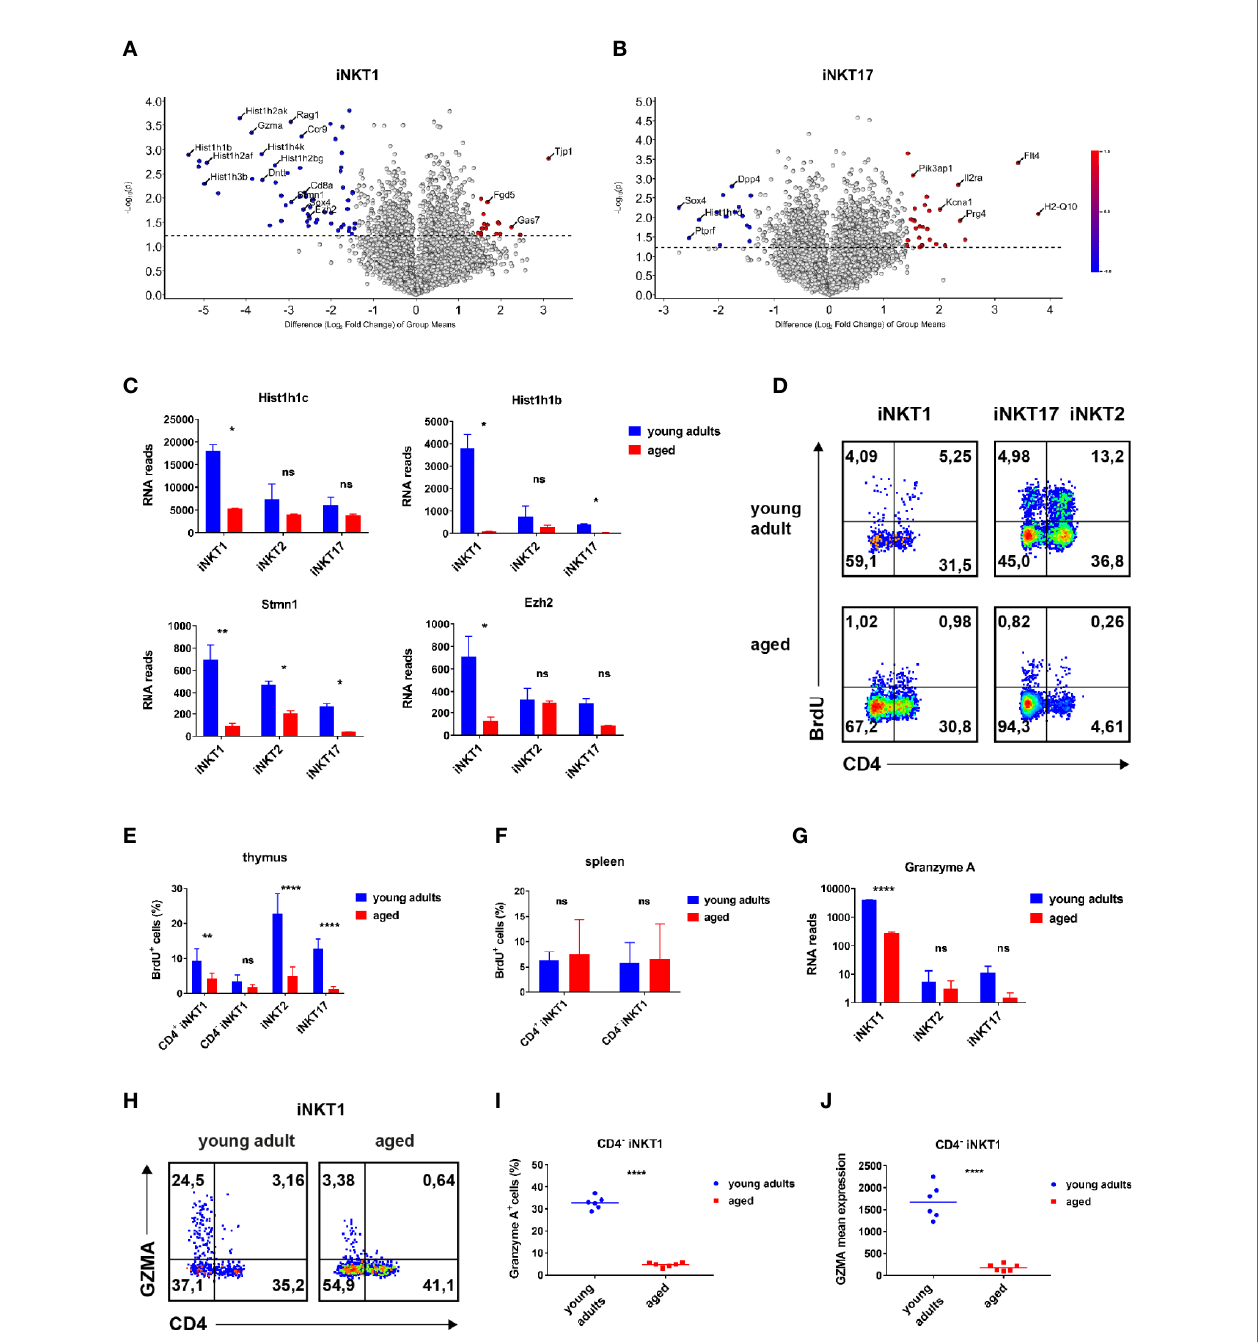
FIGURE 3 | Age-dependent expressed genes iNKT1 and iNKT17 cells. (A, B) Volcano plots illustrating genes upregulated (red dots to the right) or downregulated (blue dots to the left) in thymic iNKT1 and iNKT17 cells from aged BALB/c mice when compared to young adults (fold change ≥ 2.83, p value <0.05; otherwise genes are represented by shaded dots). Data source as in Figure 2 . (C) Hist1h1c and Hist1h1b RNA reads (mean ± sd) in thymic iNKT subsets. (D – F) BrdU detection at day 5 following BrdU administration in vivo . Gating strategy as indicated in Figure 1A . (D) Representative fl ow cytometry plots of BrdU levels in thymic iNKT subsets as indicated. (E, F) Summary of BrdU levels (mean ± sd) in thymic and splenic iNKT cells. Data were from two independent experiments with four young adult and four aged mice each. (G) Gzma RNA reads (mean ± sd) in the indicated thymic iNKT subsets. Data source as in Figure 2 . (H – J) Analysis of granzyme A expression. Gating was done as shown in Figure 1A . (H) Representative fl ow cytometry plots showing granzyme A expression in thymic iNKT1 cells. (I, J) Granzyme A + cell frequencies and mean expression among thymic CD4 − iNKT1 cells. Data were summarized from two independent experiments analyzing three young adult and three aged mice each. Two-way ANOVA followed by Sidak ’ s multiple comparisons test were performed in (C) , (E, G) . Unpaired t test was performed in (I, J) . *p < 0.05, **p < 0.01, ****p < 0.0001, ns, not signi fi